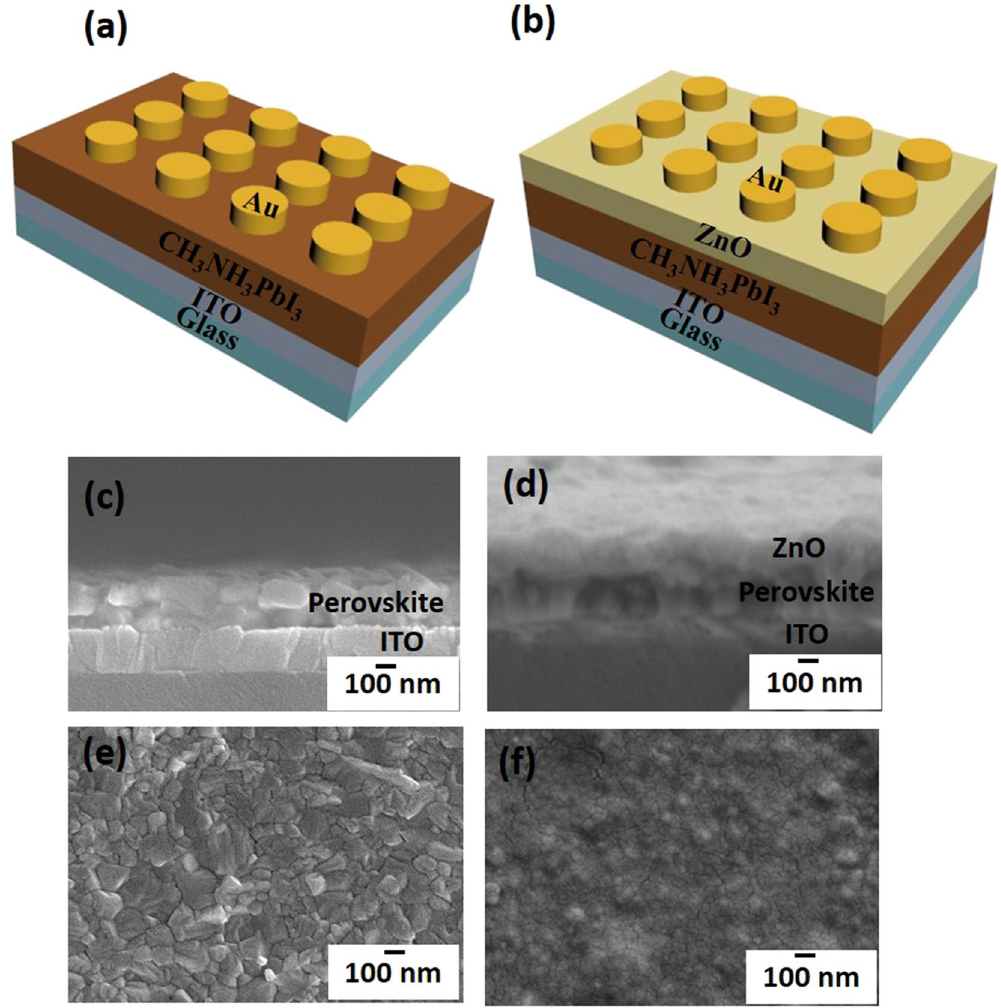
Figure 1. Schematic of ( a ) Au/CH 3 NH 3 PbI 3 /ITO devices and ( b ) Au/ZnO/CH 3 NH 3 PbI 3 /ITO devices. Cross- sectional images of ( c ) Au/CH 3 NH 3 PbI 3 /ITO devices and ( d ) Au/ZnO/CH 3 NH 3 PbI 3 /ITO devices. Plan views of perovskite ( e ) without ZnO film and ( f ) with ZnO